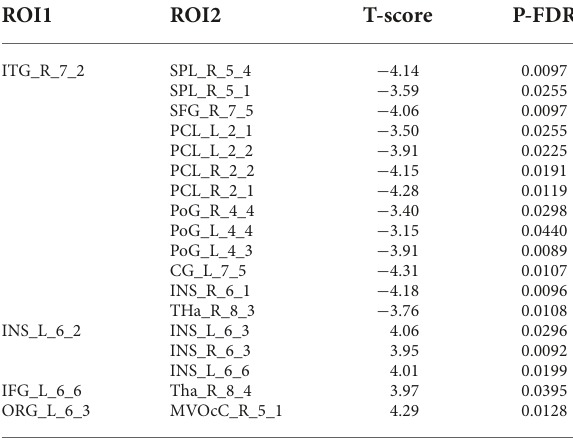
Employing the fine-tuning transfer strategy, the VGG model obtained the highest